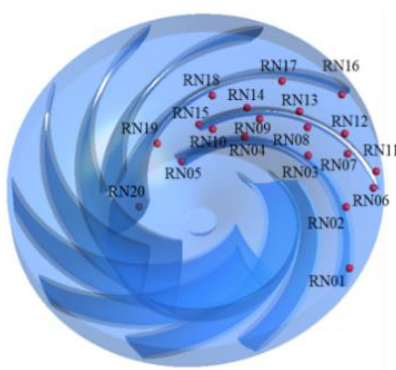
Appl. Sci. 2020 , 10 , x FOR PEER REVIEW Figure 5. Monitoring points in the runner. Figure 5. Monitoring points in the runner. Figure 5. Monitoring points in the runner.